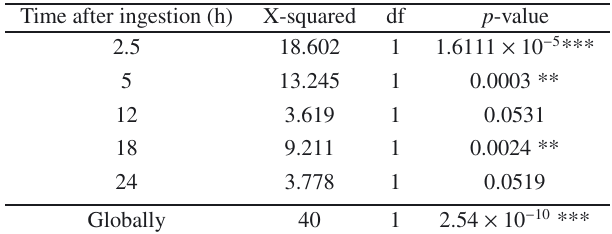
Table 3. Results of Nemenyi with post-hoc test comparing genetic and morphological identification success between each time step and Kruskal-test globally. * indicates levels of significance ( p < 0 .